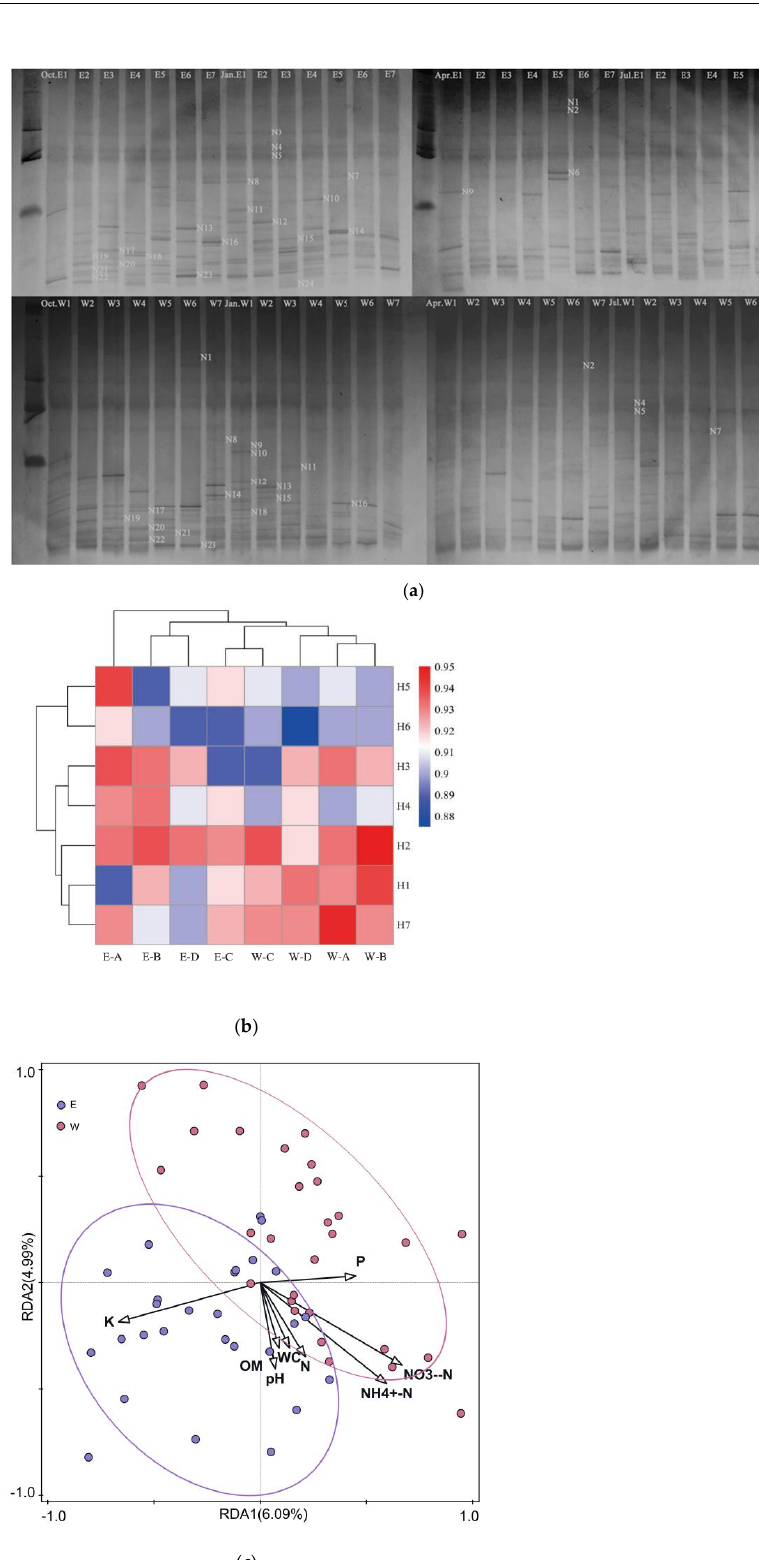
Figure 2. ( a ) Denaturing gradient gel electrophoresis (DGGE) analysis of the nifH genes obtained from forestry Ailao Mountain soils (E and W: east and west, respectively. 1, 2, 3, 4, 5, 6, 7: the elevations of the Ailao Mountain sampling sites). ( b ) Heat map and hierarchical clustering analysis of soil nitrogen − fixing bacteria diversity with different altitude gradient, seasonal changes and slope aspect. ( c ) Redundancy analysis (RDA) of physical − chemical parameters (E and W: east and west, respectively).